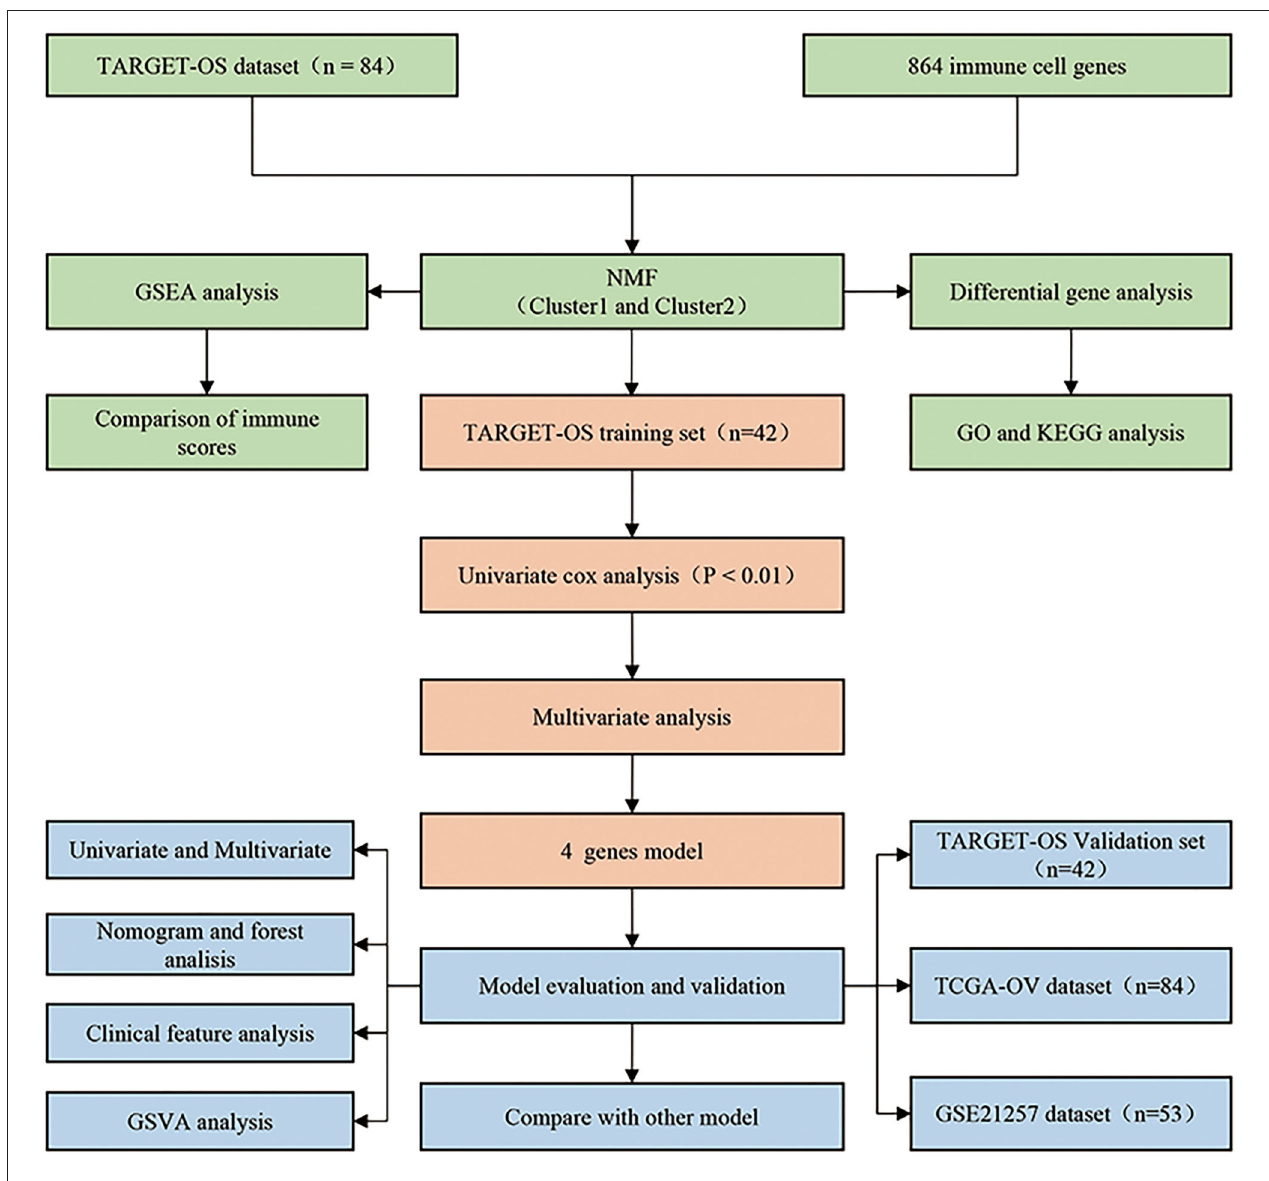
FIGURE 1 | Osteosarcoma research